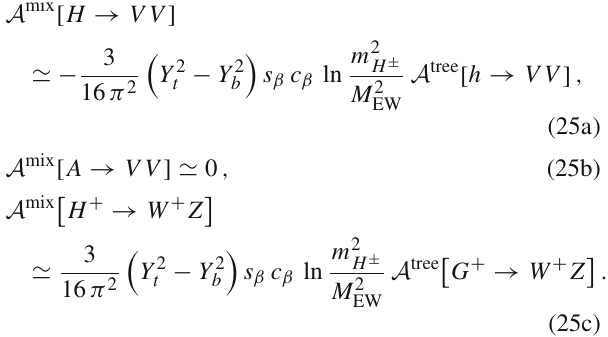
Fig. 9 Decay widths of heavy-doublet states into top quarks are shown for t β = 10 and m SUSY (cid:16) 100TeV. Left: The mixing contributions to the CP -even channel are computed with Yukawa couplings at low energy (to mimic the corresponding calculation in the mixing formal- ism); other terms employ Yukawa couplings that include QCD-running up to the scale of the decaying Higgs. Corresponding results from FeynHiggs are shown as dashed curves for the neutral states – to